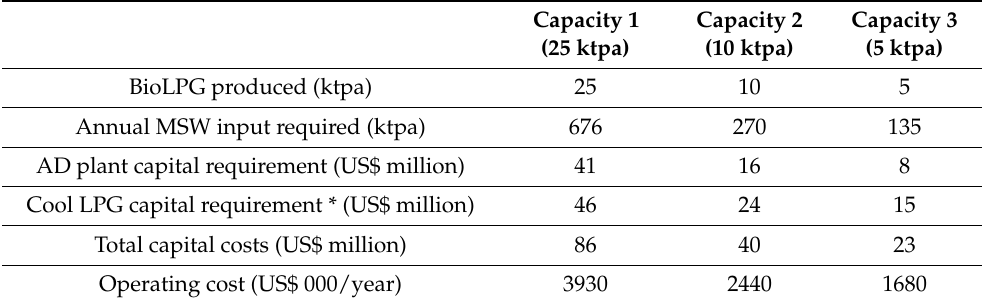
Capital and operating costs of a Cool LPG plant in Ghana or Rwanda before feedstock